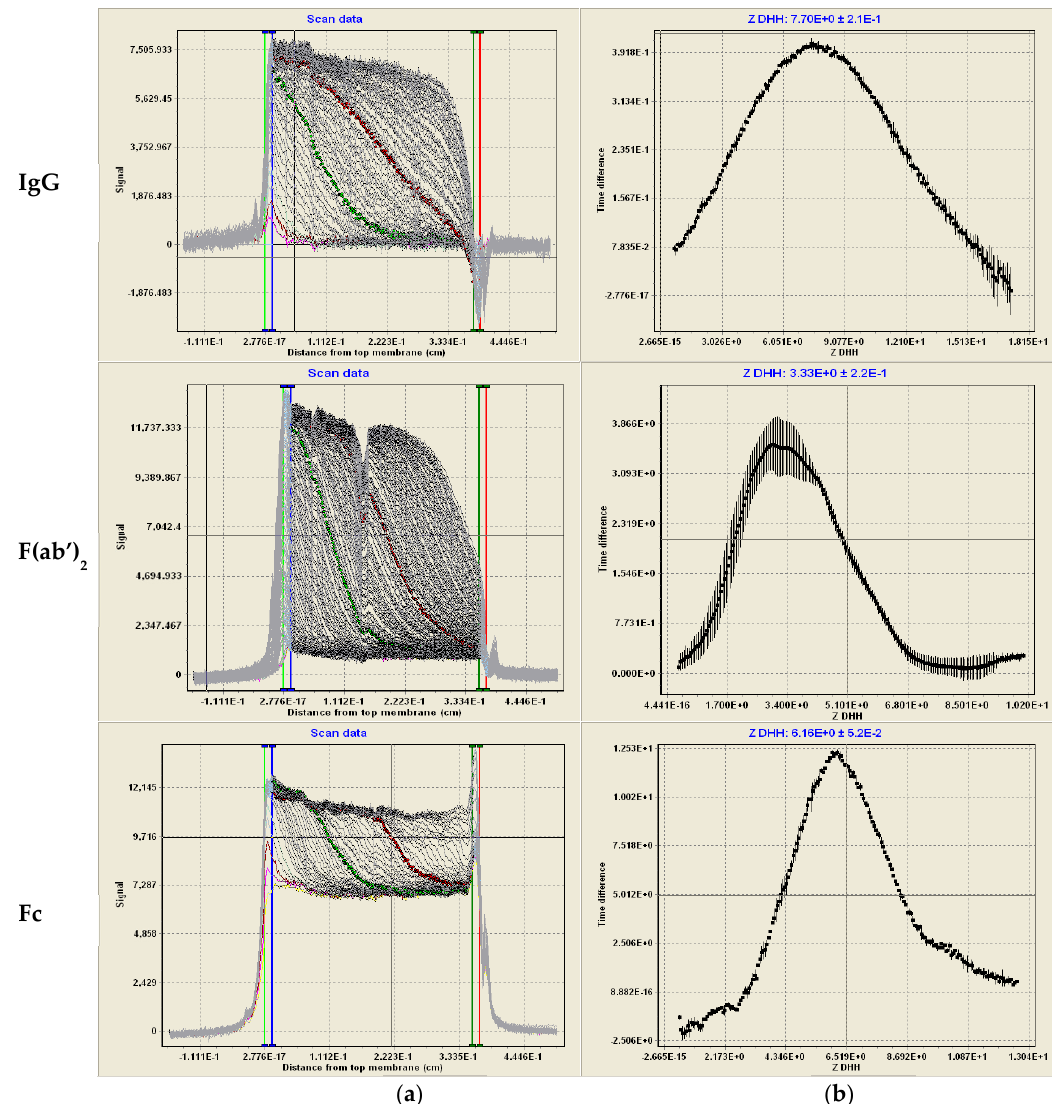
Figure 5. Z DHH determination of IgG, F(ab’) 2 , and Fc by Membrane-Confined Electrophoresis (MCE) in pH 5.0 acetate. ( a ) Raw MCE scans over time during electrophoresis. The data (left panel) shows the light intensity (I, vertical axis) as a function of the distance moved from the membrane (cm, horizontal). Time difference curves ( ∆ I/ ∆ t) are calculated from data between the green and red highlighted scans. The electrophoretic mobility distribution is calculated from distance moved from the membrane, x, divided by the product of the electric field, E, and average elapsed time for the middle scan t , µ = x ( b ) The vertical axis shows the time derivative ( ∆ I/ ∆ t) of the intensity data in panel ( a ) as a function of Z DHH (horizontal axis). Z DHH was calculated from the mobility using T = 20 ◦ C; viscosity = 0.98 cp; conductance = 16.8 mS; E = − 19.8 V/cm, D = 78; counterion radius, 0.18 nm; Stokes radius, 5.5 nm. The peak Z DHH position is displayed above the curve.